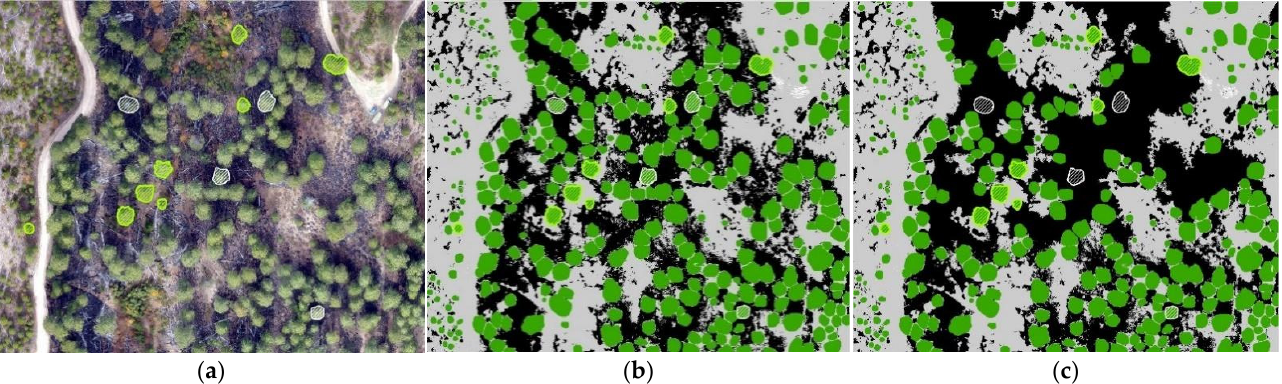
Figure 3. ( a ) Cottonwood orthomosaic imagery with calibration data polygons overlaid. The bright green polygons are trees that were marked by the human as trees, and the white polygons are trees that are completely surrounded by burned pixels, implying that the surface underneath the crown is burned, and are marked by the human as burned. ( b ) Combined raster output from the Cottonwood fire with calibration data polygons. ( c ) Output from the Sub-Crown Burn Mapping tools on Cottonwood. This image shows what the Sub-Crown Burn Mapping tools do and how they compare to calibration data that was created.